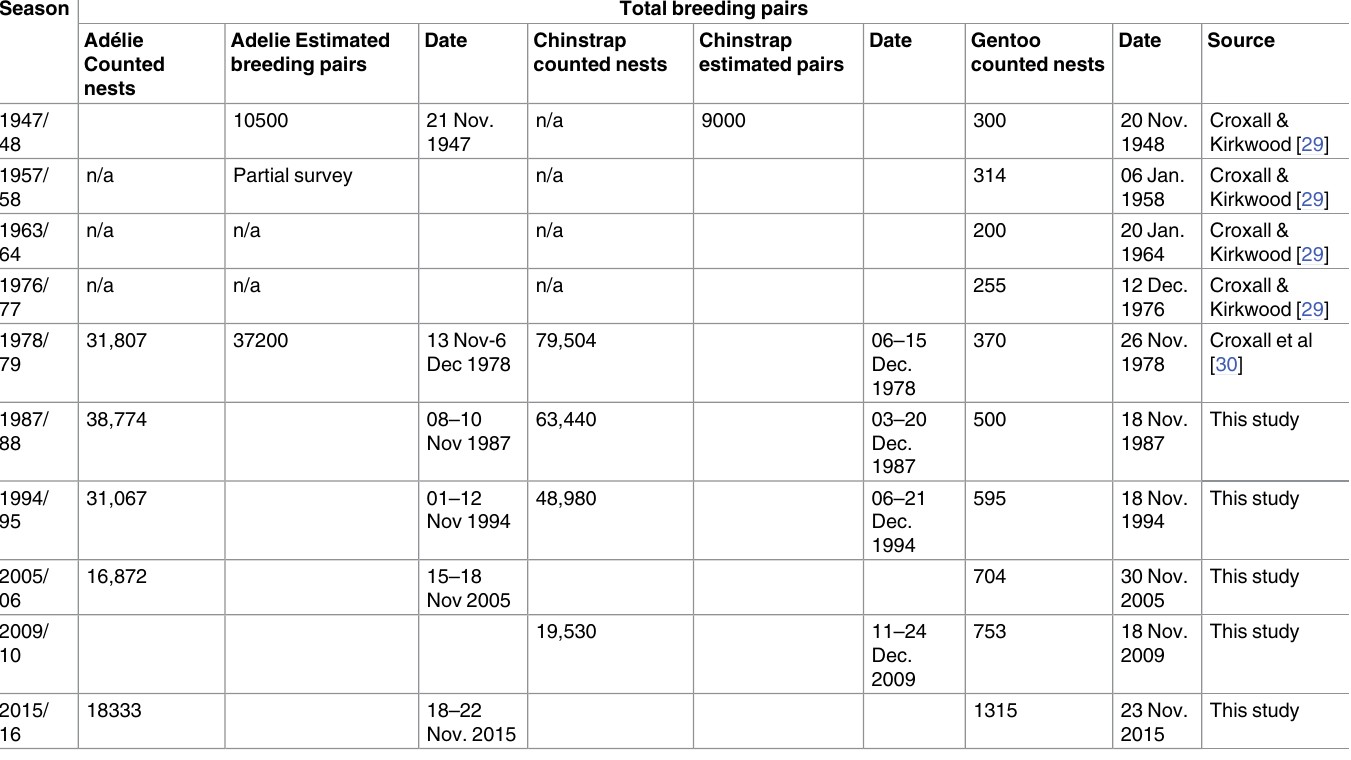
Table 1. Pairs of Ade´lie, chinstrap and gentoo penguins counted at Signy Island and offshore islands, 1947/48–2015/16. Season Total breeding pairs Ade´lie Adelie Estimated Counted breeding